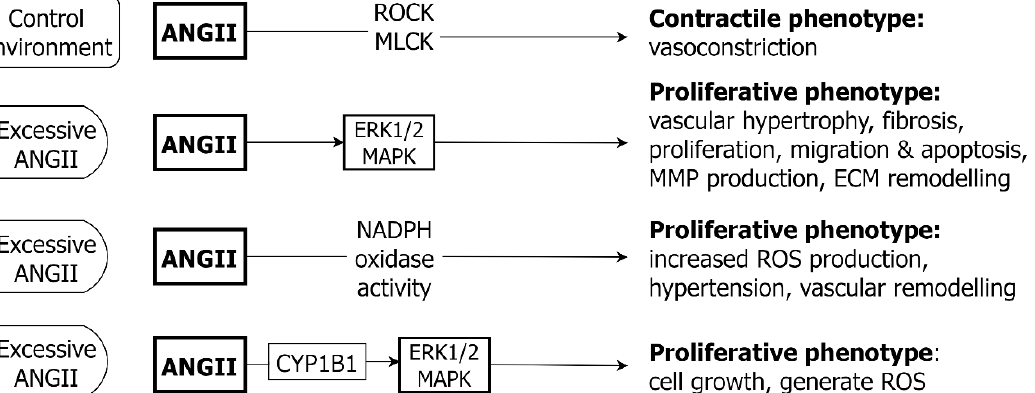
Figure 9. Summary of the mechanisms of ANGII signaling pathways in VSMC. While the immediate effect of ANGII stimulation is to maintain vascular tone, chronic and excessive stimulation of ANGII results in a proliferative phenotype. The generation of ROS results in inflammation that also promotes proliferation.